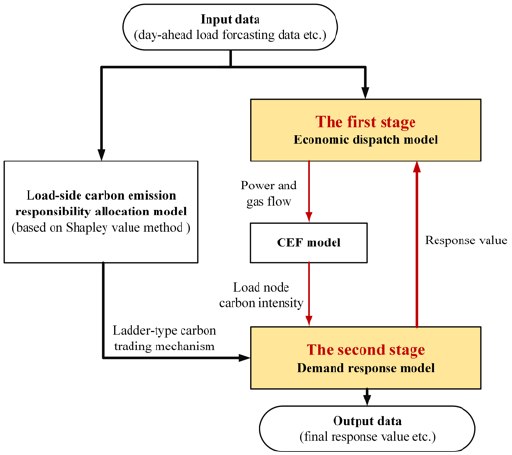
Figure 2. The framework of the two-stage mathematical